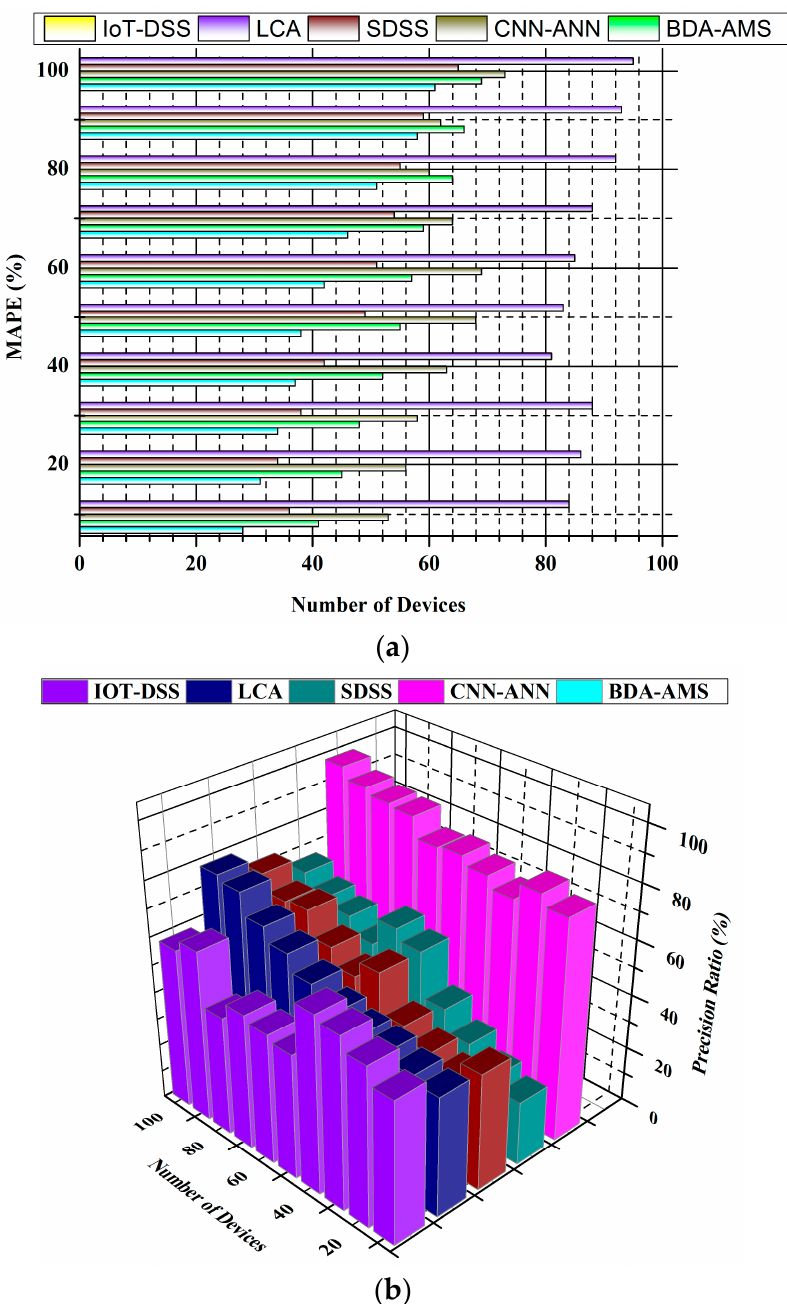
Figure 9. ( a ) Precision ratio (%). ( b ) Mean absolute ratio (%).